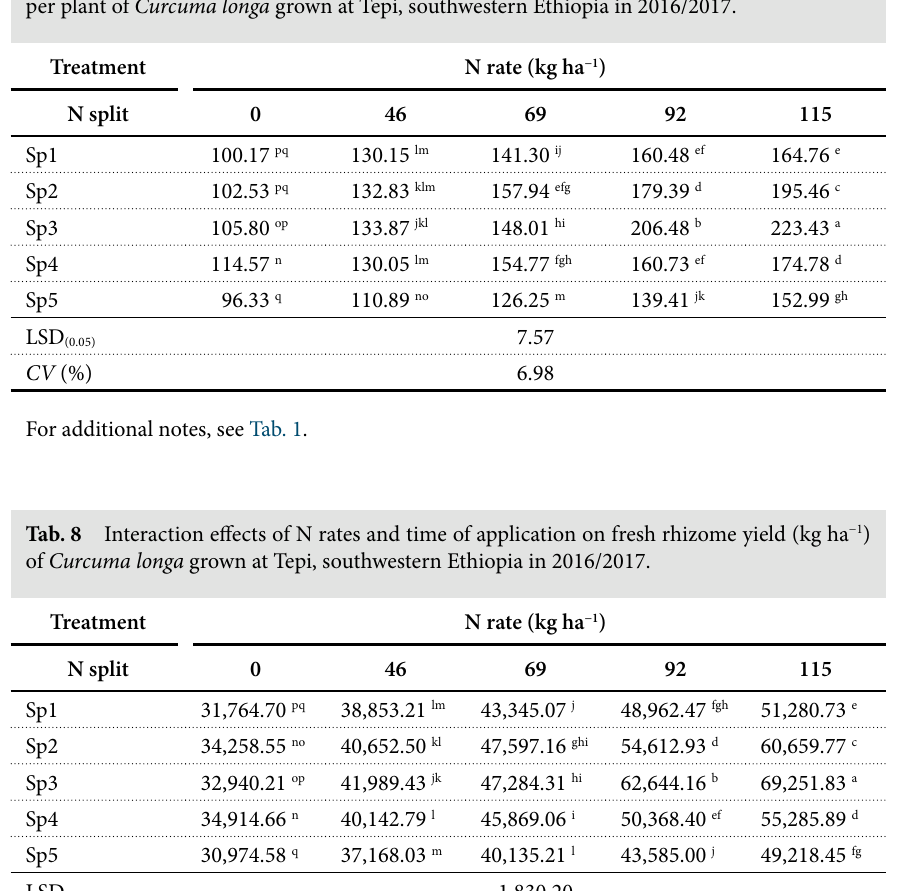
Tab. 7 Interaction effects of N rate and time of application on fresh weight of finger rhizome per plant of Curcuma longa grown at Tepi, southwestern Ethiopia in 2016/2017.